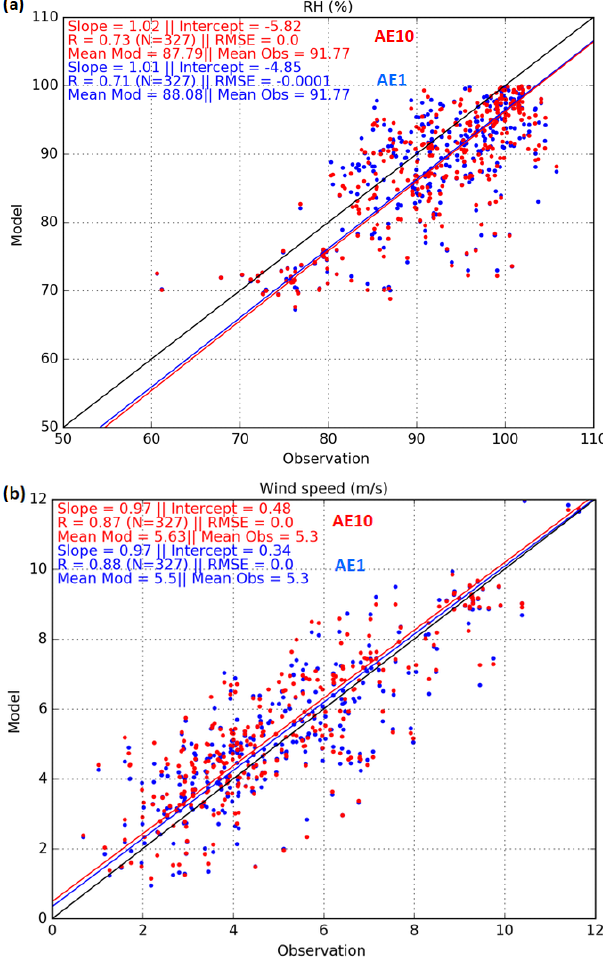
Figure 4. Scatter plot of (a) relative humidity (RH) and (b) wind speed (WS) with the 3min averaged observations against the mod- eled values interpolated along the flight positions for the two exper- iments AE1 (in blue) and AE10 (in red) below 4kma.m.s.l. (and above 300ma.m.s.l.) using all flights of the DACCIWA campaign during the period 1–7 July 2016. Statistics of a linear regression analysis are given in top left corner of each